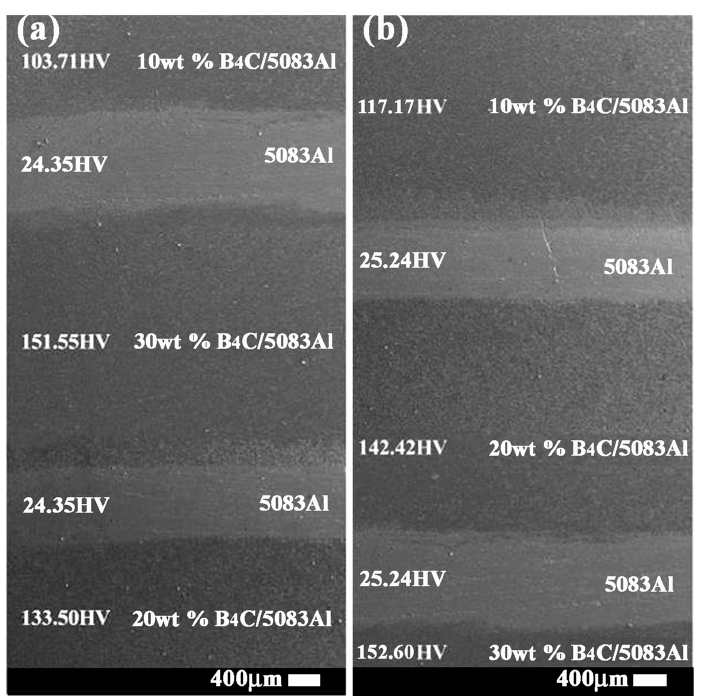
Figure 3. Layered structure and microhardness of ( a ) Bionic Meretrix lusoria shell layered composite material and ( b ) Bionic Rapana venosa shell layered composite material.